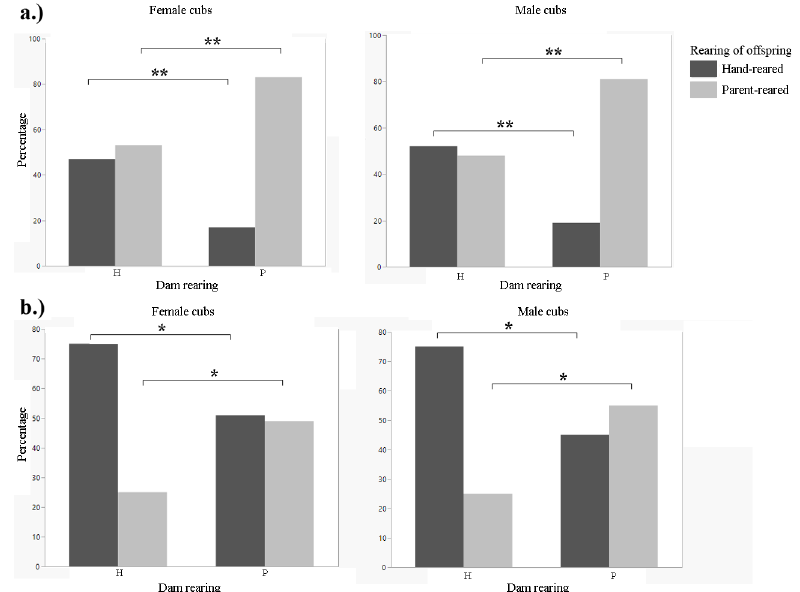
Fig 7. Percentage of female and male offspring that were reared by their dams or hand-reared (2000 – 2011). A). cheetah B). clouded leopard. Fisher's exact test: * p < 0.05; ** p <